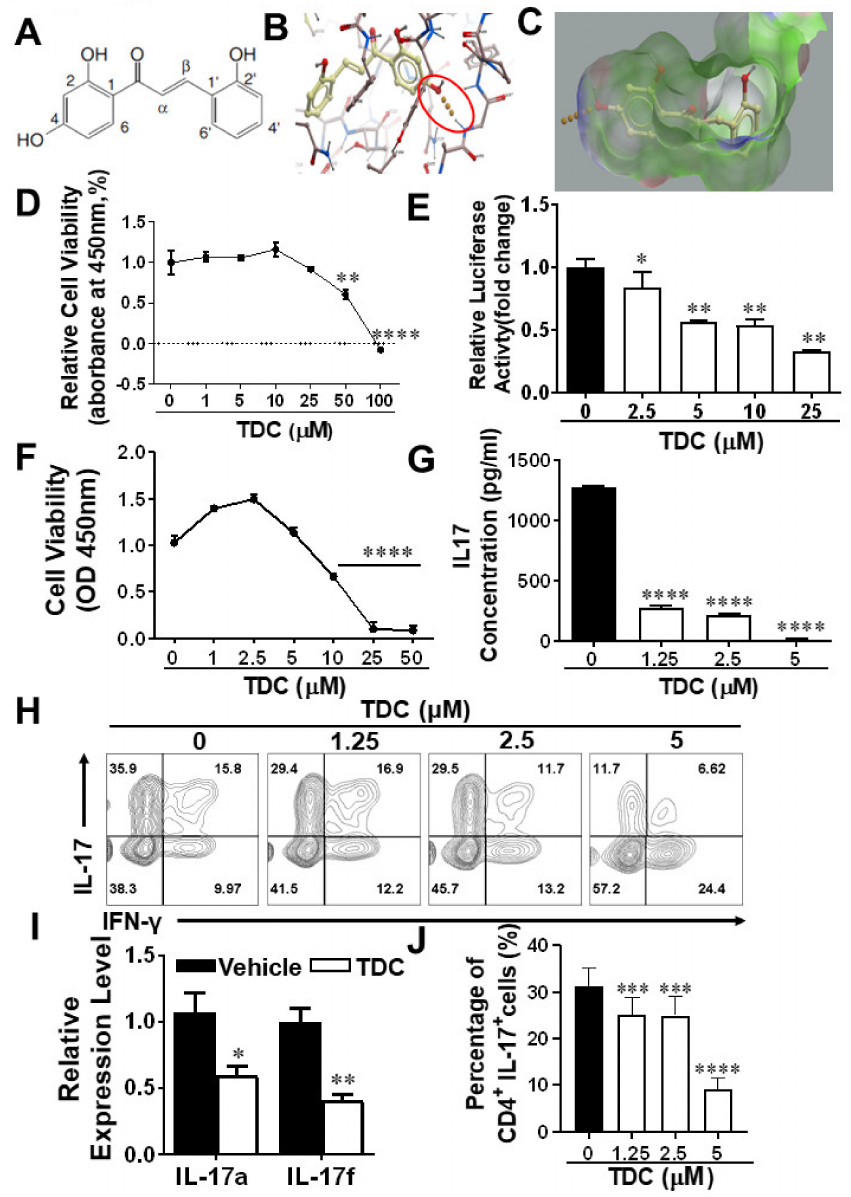
Figure 1. Molecular docking and inhibition of Th17 cell differentiation by TDC targeting ROR γ t. ( A ) Structural formulas of compound TDC. ( B ) Hydrogen bond connections between TDC and A496 in pocket 1 of ROR γ t protein (PDB: 5C4T). ( C ) The electron cloud distribution stated TDC binds with V494, F506, W317, I492, and L325 in pocket 1 of 5C4T protein. ( D ) The effect of various concentrations (1–100 µ M) of TDC on the viability of HEK293T cells overexpressing mROR γ t. ( E ) The impact of TDC on the activity of ROR γ t luciferase reporter gene. ( F ) The influence of TDC on splenocyte cell viability. ( G ) The level of IL-17 production in Th17 cells after TDC treatment by ELISA. ( I ) qRT-PCR was performed to test IL-17a and IL-17f genes in TDC and vehicle-treated groups. ( H , J ) Intracellular IL-17 staining was used to evaluate the influence of TDC treatment on Th17 cell differentiation by flow cytometry. Data are shown as mean ± SD ( n = 3 each group) and representative three experiments. * p < 0.05, ** p < 0.01, *** p < 0.001, **** p < 0.0001, compared to control group, and determined